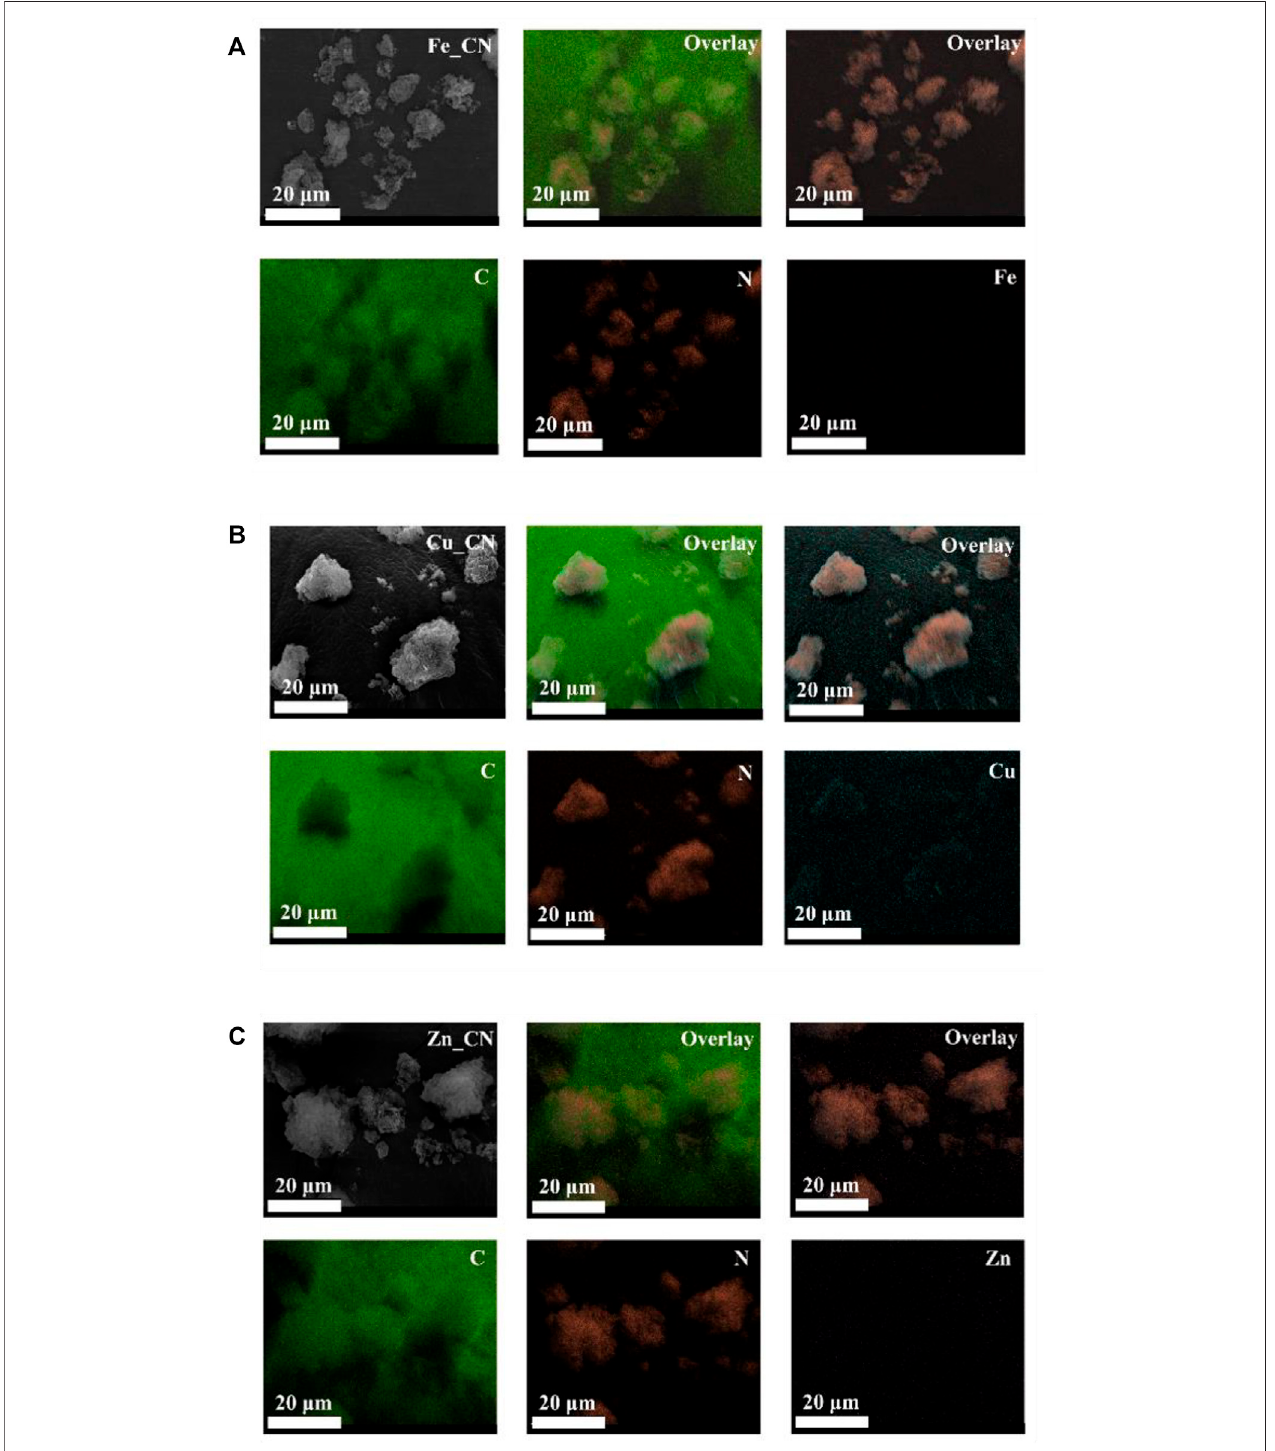
FIGURE 1 | EDX mapping for single metallic doping systems (A) Fe_CN, (B) Cu_CN, and (C) Zn_CN.